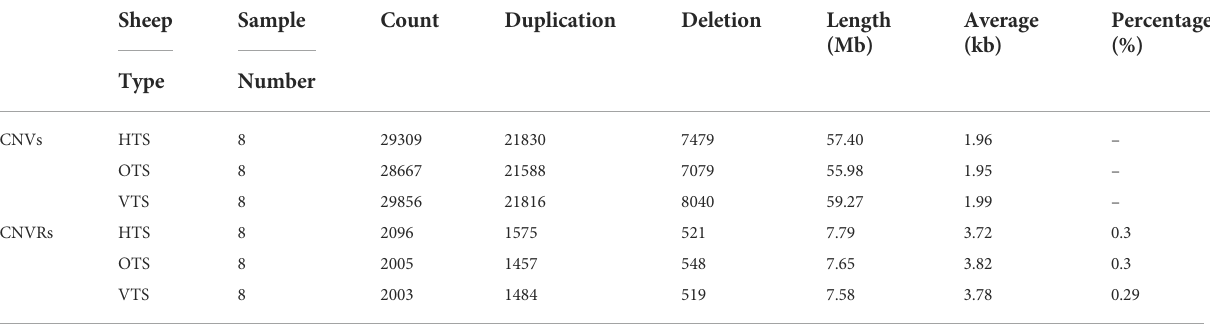
TABLE 1 Summary of CNVs and CNVRs identi fi ed in three Tibetan sheep populations. Sheep